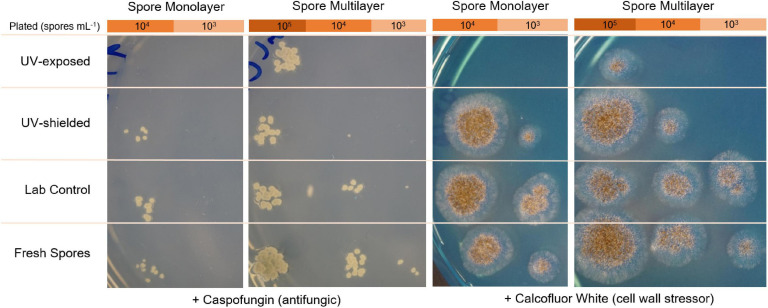
Stress resistance of A. niger towards caspofungin (antifungal compound) and to calcofluor white (cell wall stressor), after spore exposure to simulated martian conditions.